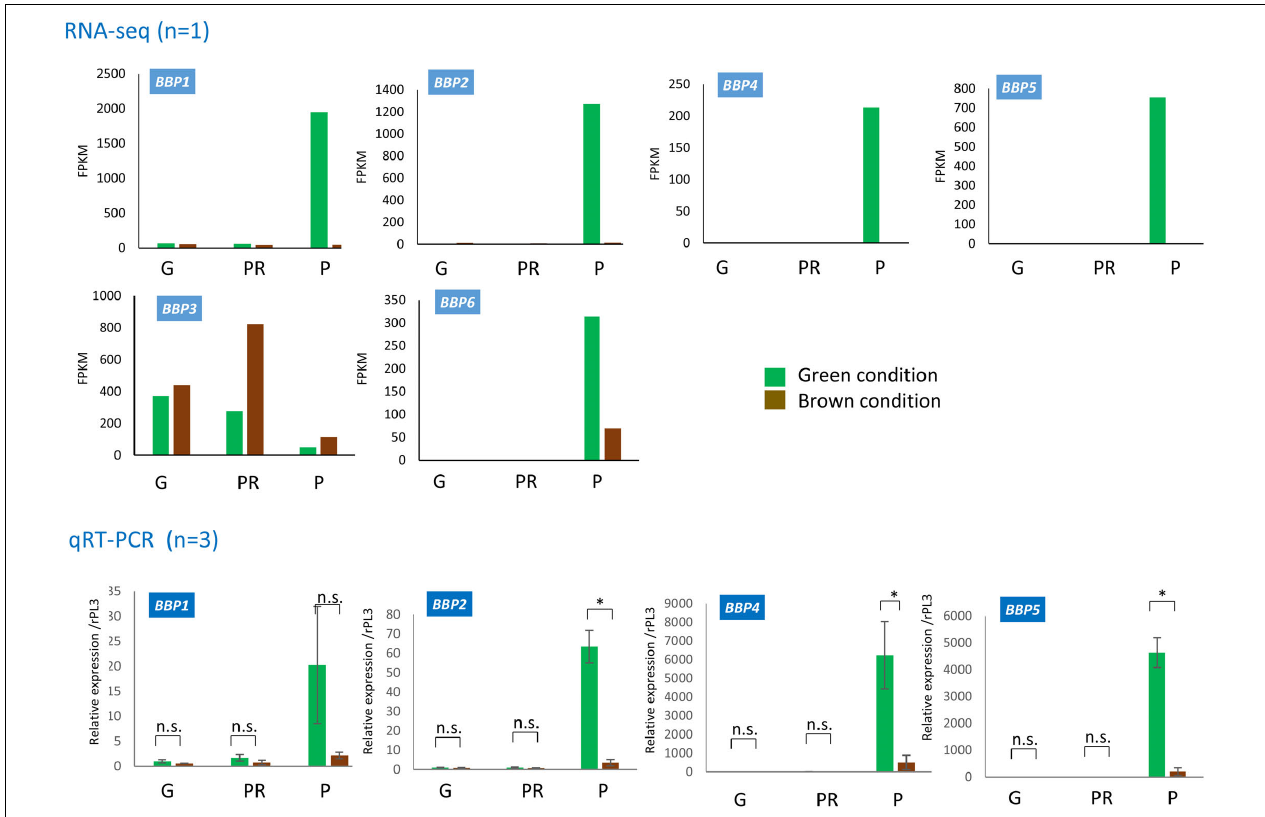
FIGURE 5 | Expression profiles of BBP genes during the pre-pupal stage and at pupation under green (GC) and brown conditions (BC). RNA-seq data (upper) and qRT-PCR data (lower) for BBP1 , BBP2 , BBP4 , and BBP5 are shown. For BBP3 and BBP6 , only RNA-seq data are shown. G, girdling (sampling at 6–7 h after gut purge); PR, proleg release (sampling at 8–10 h); P, pupation (sampling at 24–30 h). Respective RNA-seq data ( n = 1) obtained upon candidate gene screening are shown as FPKM. We estimated the expression level of qRT-PCR data using RpL3 as an internal control. Error bars in qRT-PCR data indicate SD ( n = 3). ∗ p < 0.05 for Student’s t